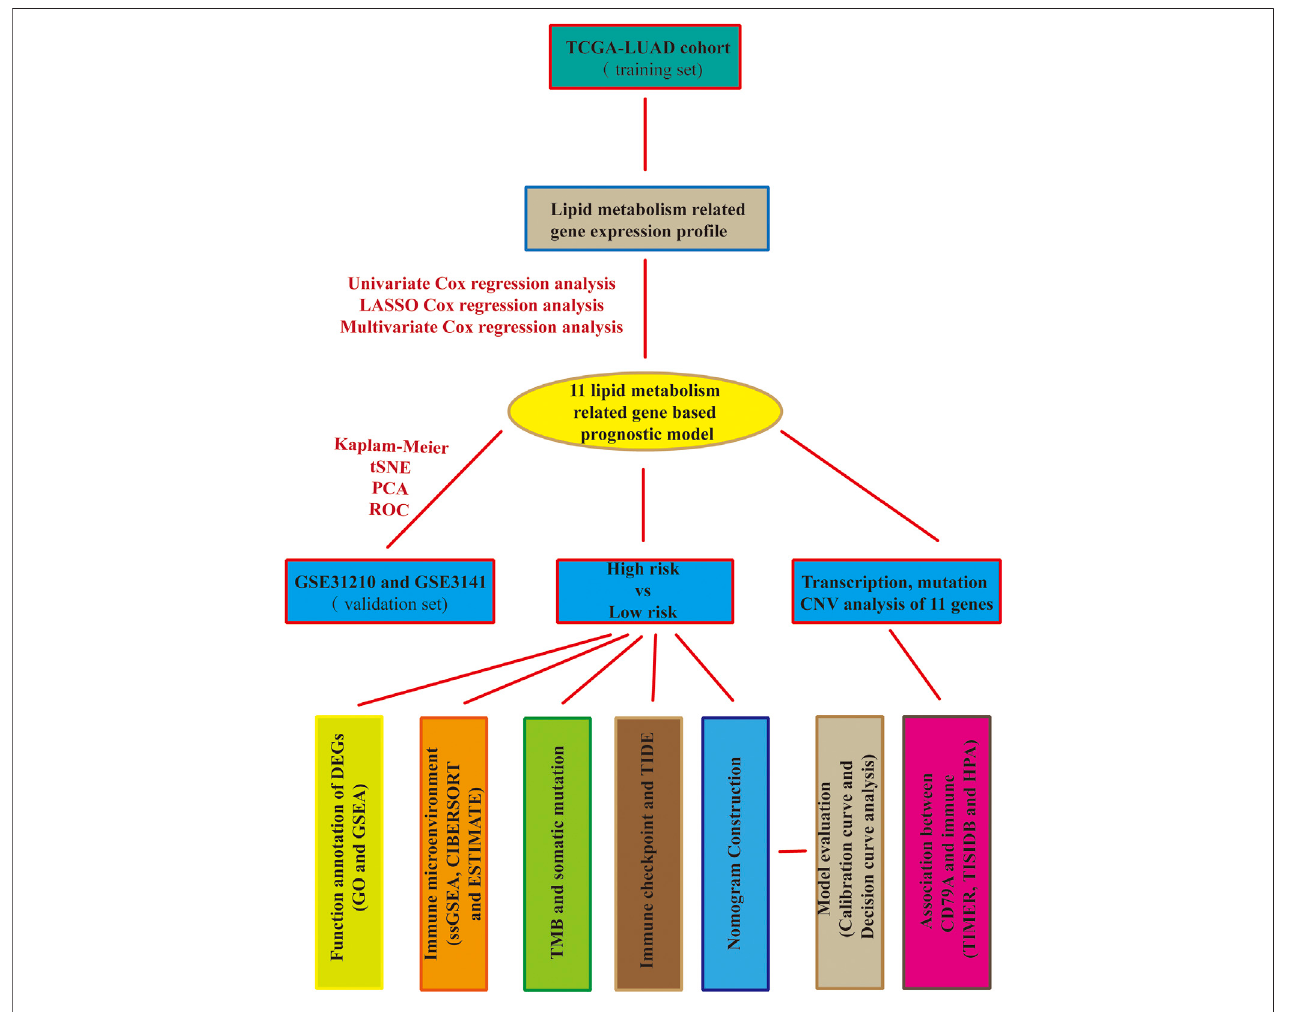
FIGURE 1 | Flow chart of this